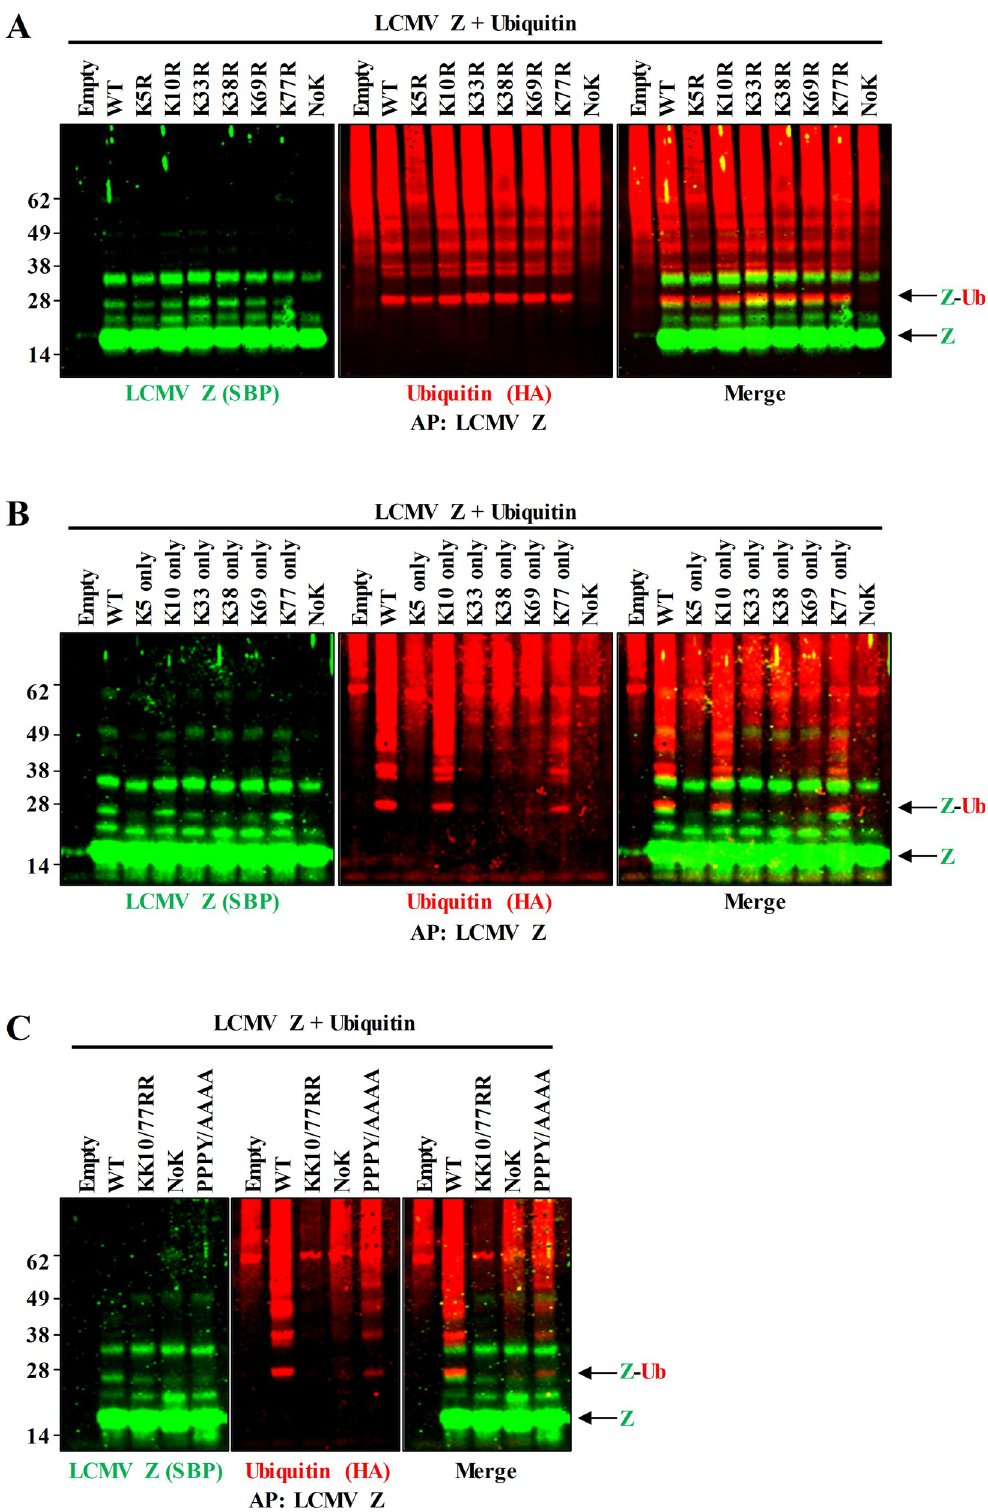
Fig 6. The LCMV Z protein is ubiquitinated at lysines 10 and 77. (A) Plasmids expressing SBP-tagged LCMV Z WT, Z containing lysine to arginine mutations at each of the six lysine residues, Z-NoK, or an empty vector were transfected into HEK293T cells along with a plasmid expressing HA-tagged ubiquitin (HA-Ub) and then two days later Z was